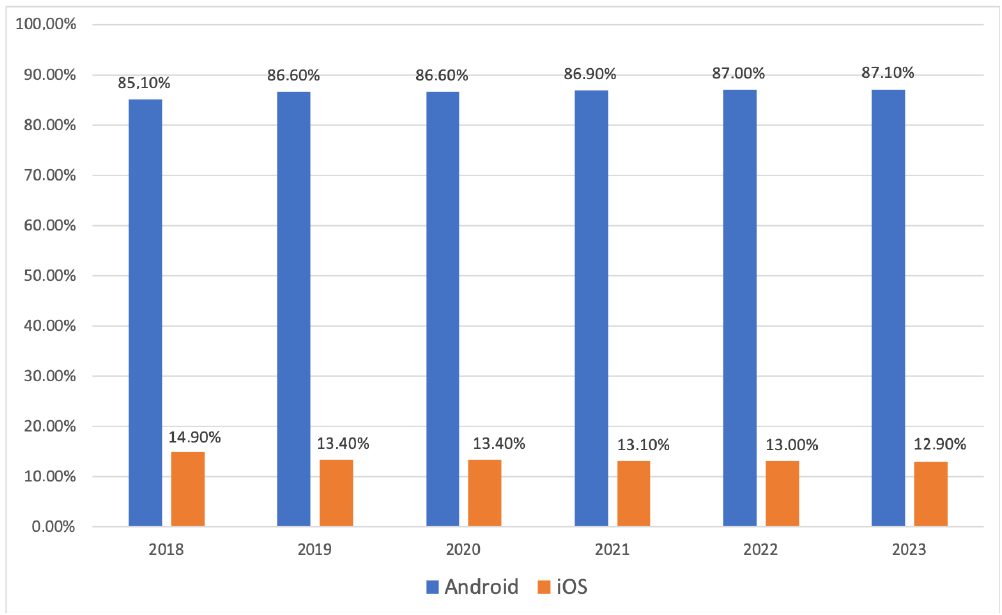
Figure 1. Smartphone operating system market share forecast